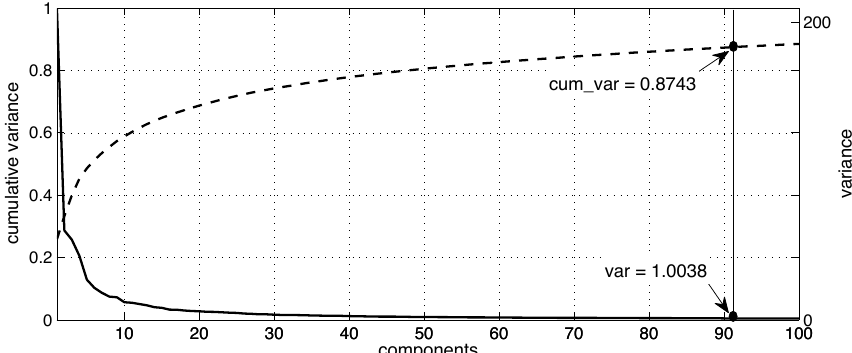
Figure 5. A subset of the first one-hundred components calculated by the PCA method: Variance values shown in straight line, and cumulative variance shown in dashed